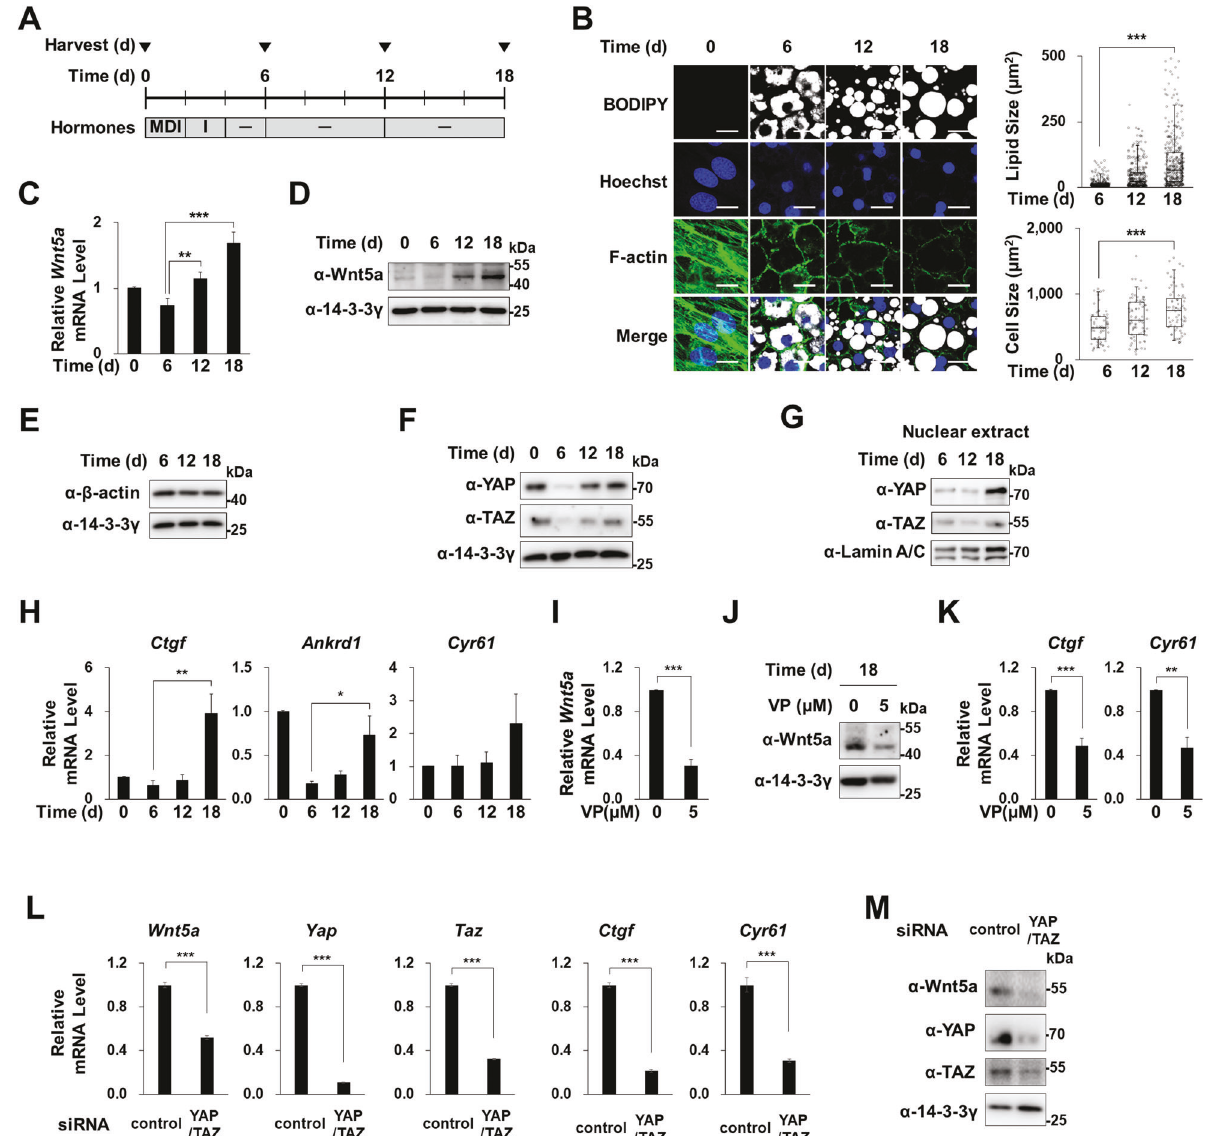
visualized by staining with Phalloidin-Alexa555, BODIPY 493/503, or Hoechst 33258, respectively (left panel). Sizes of lipid vacuoles and cells were measured in BODIPY stained areas and F-actin covered areas, respectively, using ImageJ. 58~74 cells were observed at each time